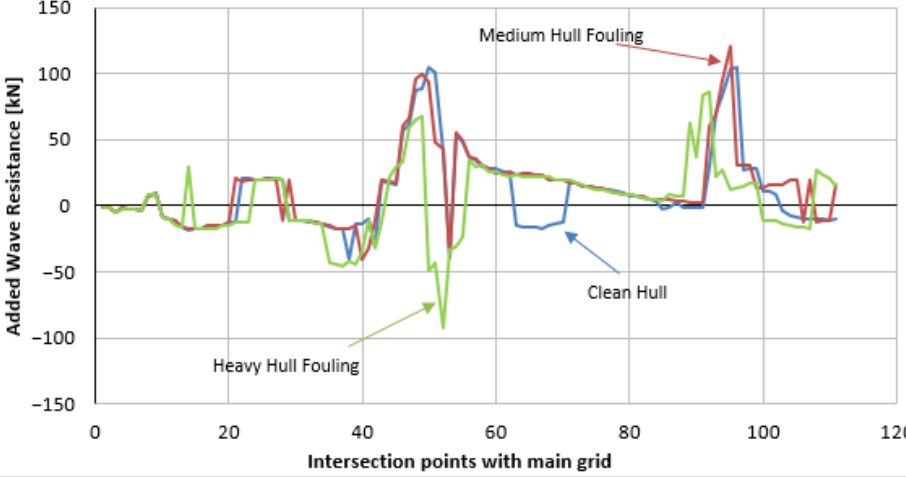
Figure 10. Added wave resistance corresponding to optimum paths for different hull fouling con- ditions.